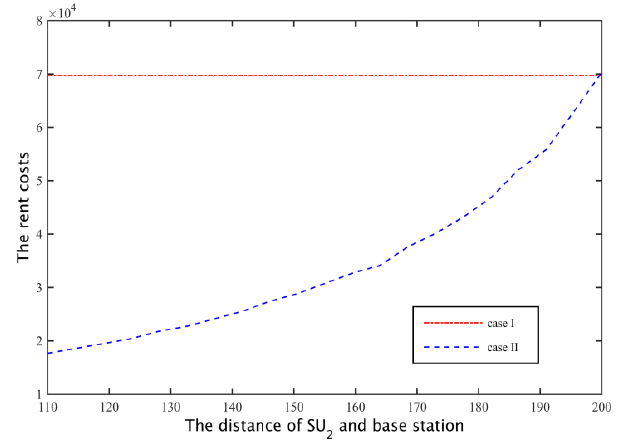
Figure 19. The cost of two secondary network leased spectrum cases.